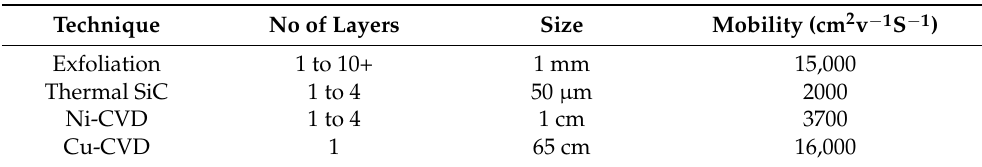
Table 2. Comparison of layer numbers, layer sizes, and electronic mobility using different graphene synthesis methods